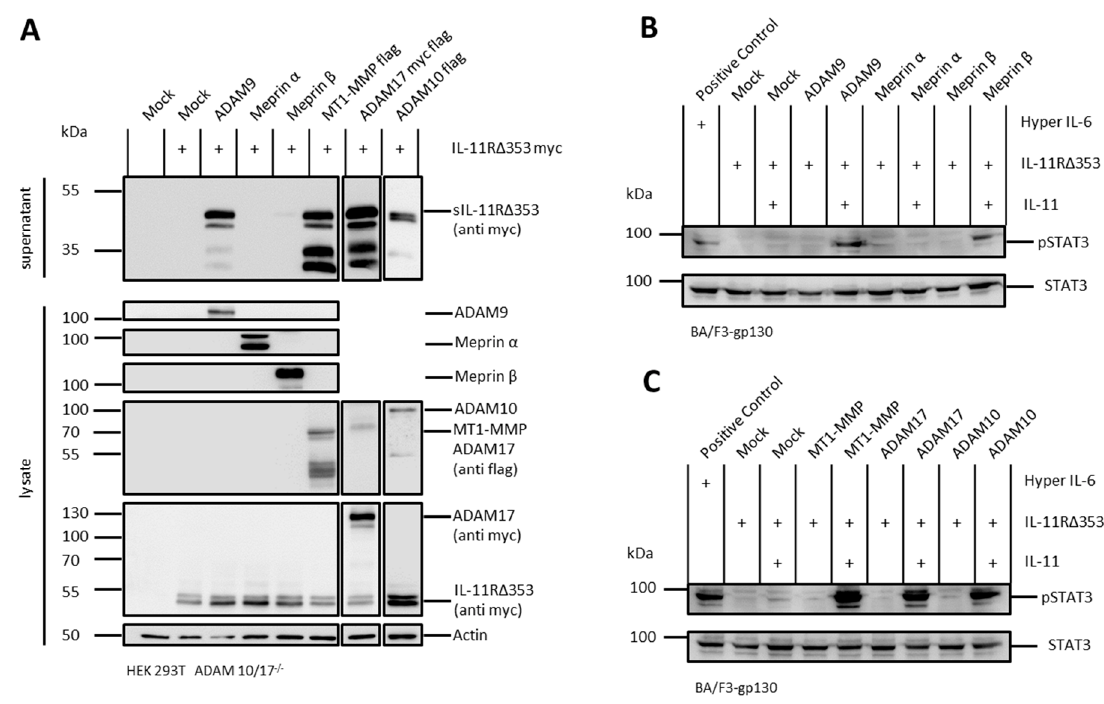
Figure 3. Shedding of the IL-11R ∆ 353 in HEK293T ADAM10 / 17 − / − cells. ( A ) HEK293T ADAM10 / 17 − / − cells were transfected with a N-terminally myc-tagged variant of the IL-11R ∆ 353 and ADAM9, meprin α , meprin β , MT1-MMP, ADAM17, or ADAM10. Supernatants were ultracentrifuged, TCA-precipitated, and analyzed by immunoblotting with di ff erent antibodies. pcDNA3.1 served as mock and actin as loading control. Cotransfection of IL-11R ∆ 353 and ADAM10 was performed in an independent experiment. ( B ) Phosphorylation of STAT3 in Ba / F3-gp130 cells stably transfected with gp130. Cells were treated with supernatants from the experiments in ( A ) and with recombinant IL-11. Phosphorylation of STAT3 was analyzed for cotransfection of IL-11R ∆ 353 with ADAM9, meprin α , and meprin β . A fusion protein consisting of soluble IL-6R and IL-6 (Hyper IL-6) served as positive control. Mock control from ( A ) served as negative control. Phosphorylation was detected with an antibody raised against phosphorylated STAT3. Total STAT3 protein served as loading control. ( C ) Same experimental setting as in ( B ) but for MT1-MMP, ADAM17, and ADAM10 as IL-11R ∆ 353 sheddases.